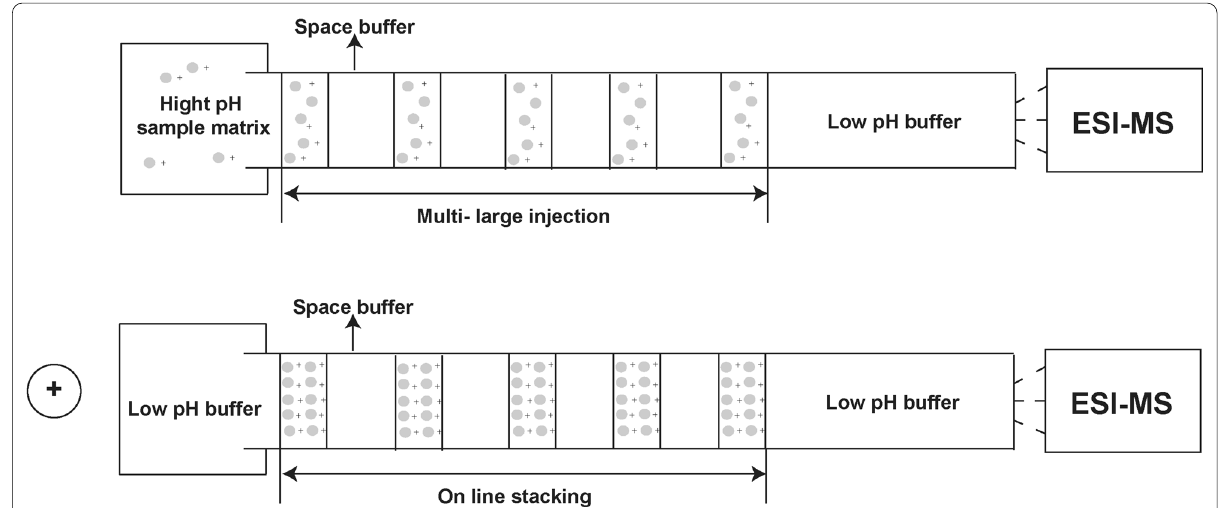
Fig.1 Multiplexed separation based on serial injection five discrete sample segments within a single capillary